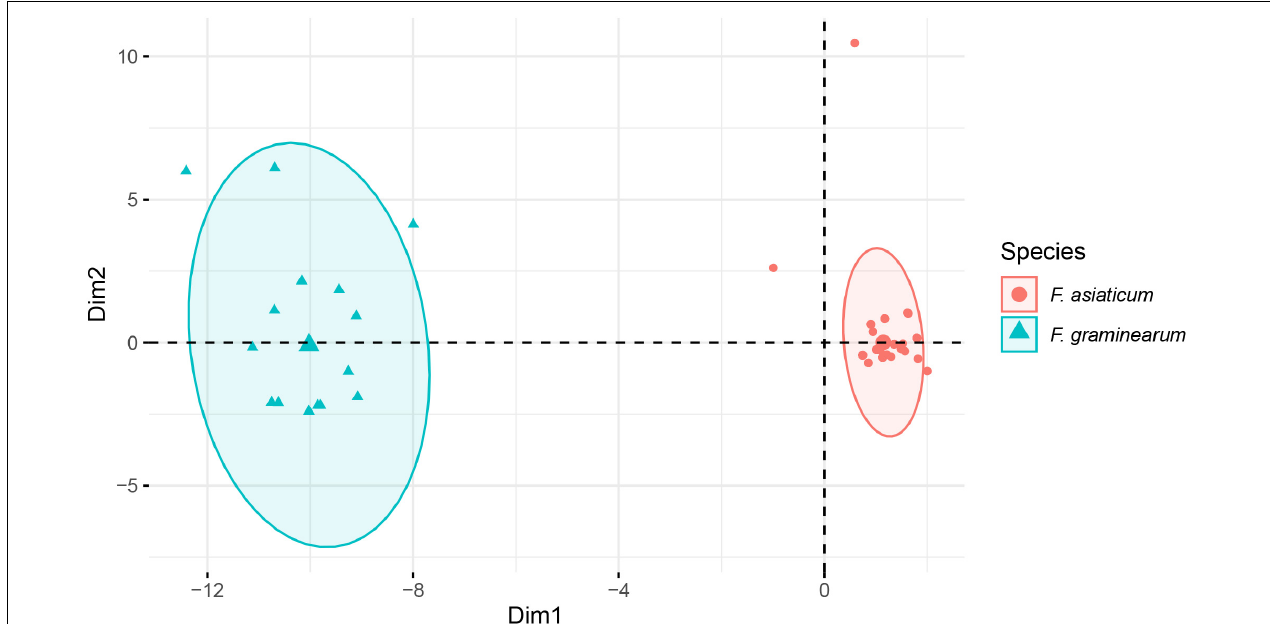
FIGURE 7 | Principal component analysis of intron regions of F. asiaticum and F. graminearum mitogenomes.